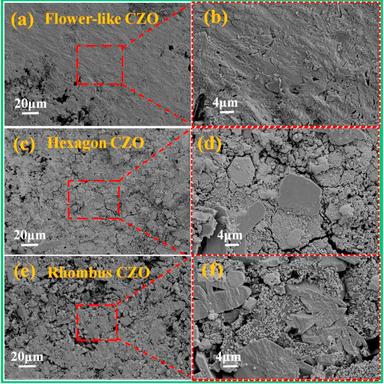
Ex-situ FE-SEM images of the (a, b) Flower-like calcium zincate, (c, d) Hexagon calcium zincate and (e, f) Rhombus calcium zincate electrodes in the discharged state after 400th charge-discharge cycles at different magnifications.